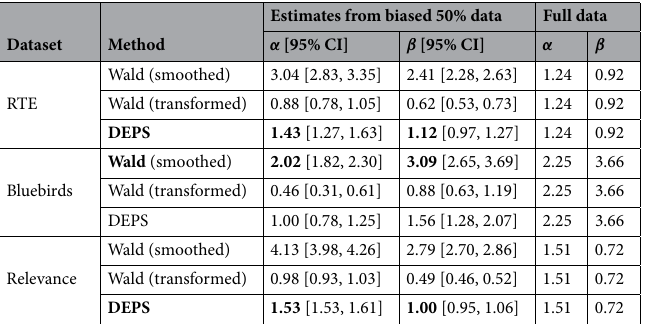
Table 1. Parameter estimates using a biased sample compared to parameters inferred using the full, unbiased dataset. Bold denotes sample estimates that are closest to estimates from the full data.